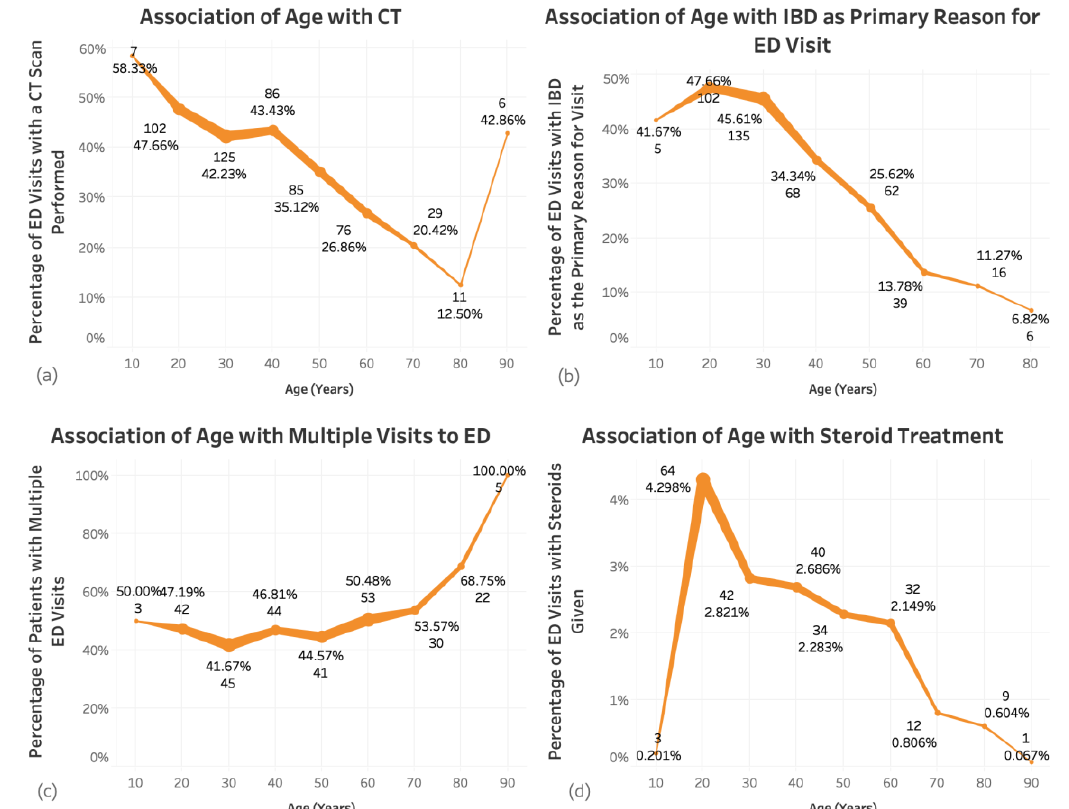
Figure 3. Association of age with: CT scan ( a ), IBD as primary reason for visit ( b ), multiple ED visits ( c ), and steroid treatment ( d ). Percentage of visits out of the total number of visits for each age grouping is shown on the x-axis. Line thickness indicates the number of visits, with thicker lines representing more visits. Older age was associated with decreased risk of a CT scan ( p ≤ 2.2 × 10 − 16 , coefficient − 0.002), decreased risk of steroid use ( p = 4.039 × 10 − 9 , coefficient − 0.0008), and increased likelihood of having multiple ED visits ( p = 0.005, coefficient 0.001).